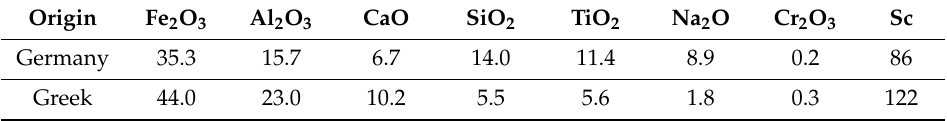
Table 2. Content of oxides in the red mud samples wt.% or ppm